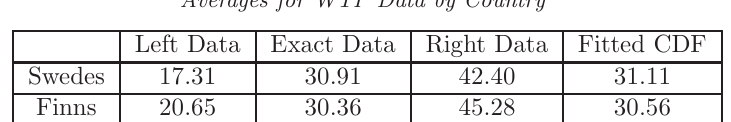
Averages for WTP Data by Country Left Data Exact Data Right Data Fitted